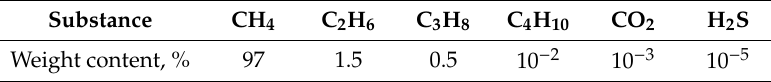
Figure 1. Simulation system for the inner surface hydrogenation in the intensified corrosion conditions: 1—reactor, 2—casing, 3—heater element, 4—methane gas canister, 5—pressure controller, 6—manometer. Table 2. summarizes the gas mixture components supplied to the gas reactor. Table 2. Percentage of gas mixture components.